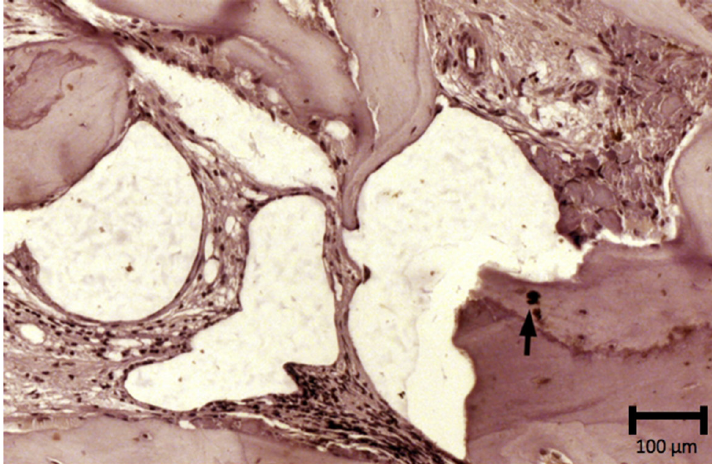
Figure 7- Histological section showing positive immunolabeling in cells for TRAP (→) in group 2. Harri’s hematoxylin stain, x25 magnification